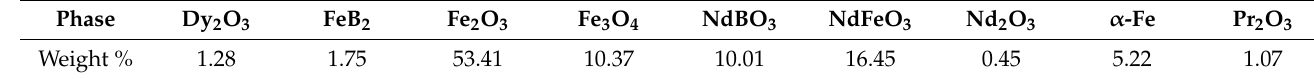
Table 5. XRD analysis of the oxidized NdFeB samples.